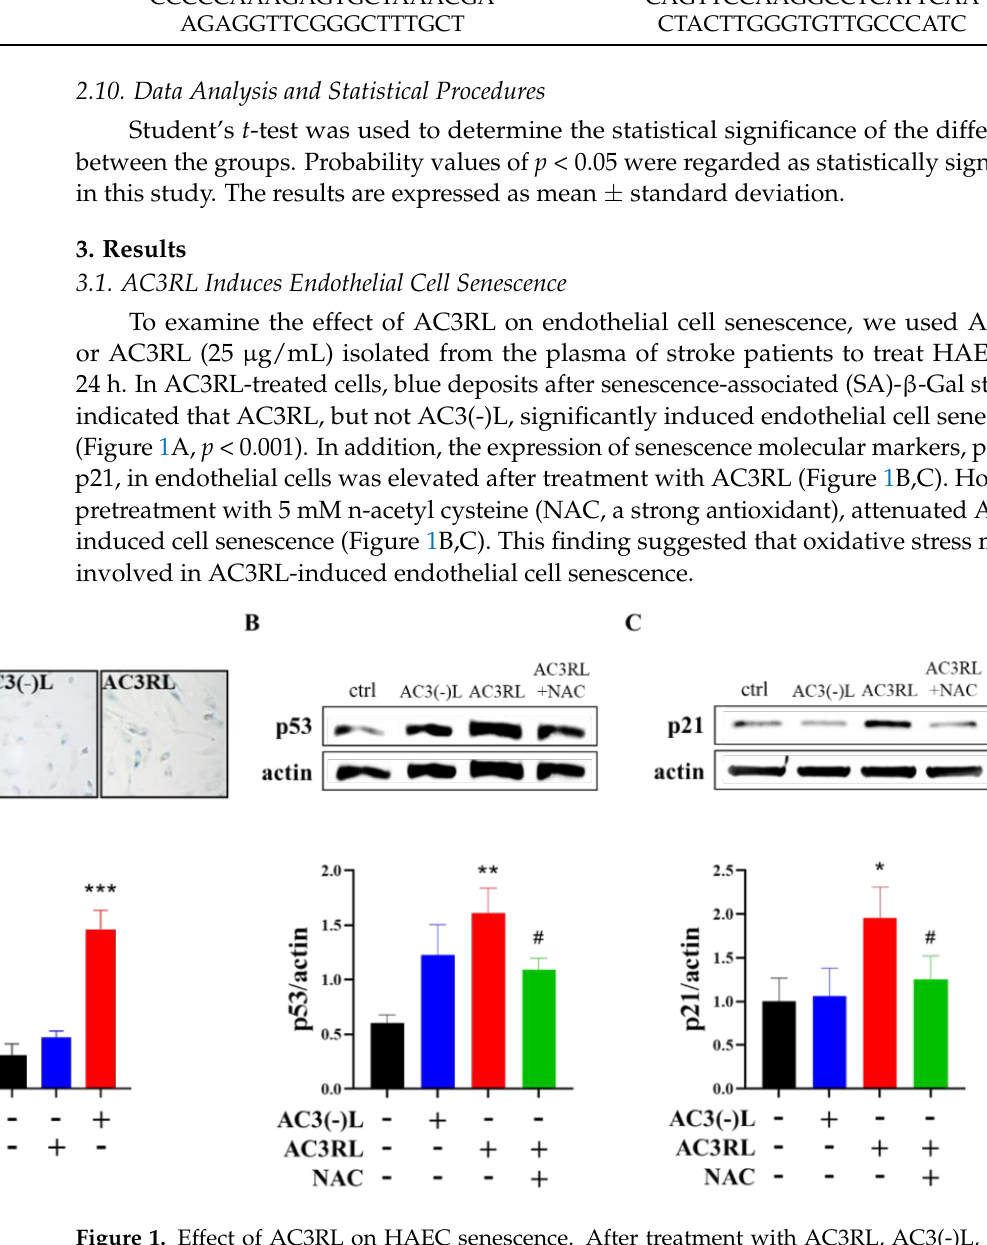
Figure 1. Effect of AC3RL on HAEC senescence. After treatment with AC3RL, AC3(-)L, or PBS, HAECs were stained with SA- β -Gal (blue) and positively stained cells were quantified in ( A ). A Western blotting assay was used to assess ( B ) p53 expression and ( C ) p21 expression. For the quantitative analyses, n = 3 per group. * p < 0.05, ** p < 0.01, *** p < 0.001 vs. control; # p < 0.05 vs. AC3RL.